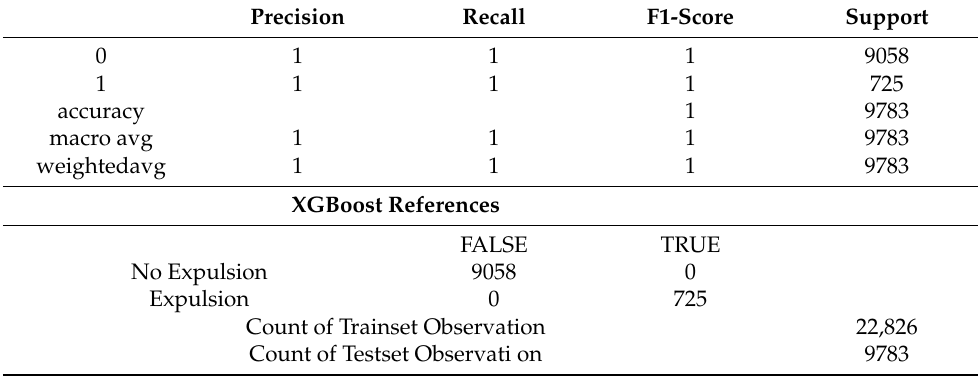
Table 14. Confusion matrix for XG Boost.